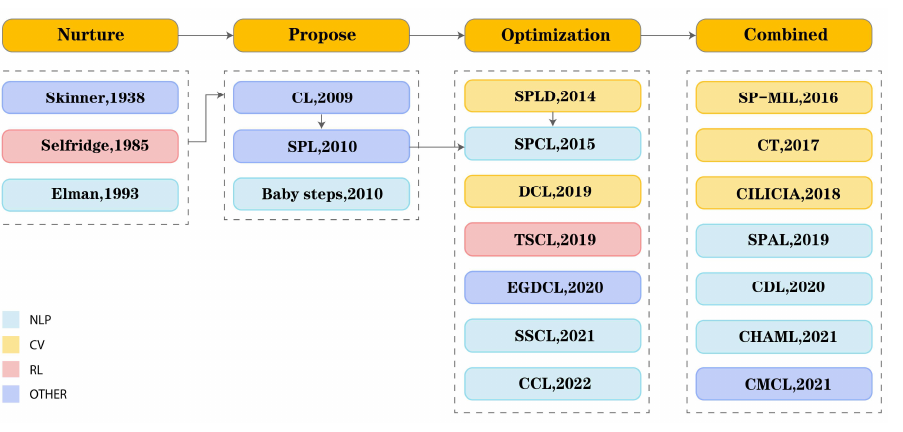
Figure 2. Research